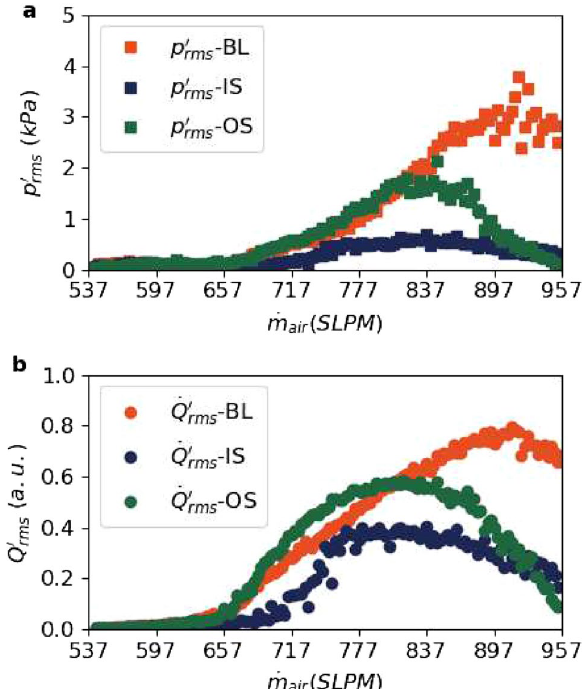
Figure 5. Time series of rms of the state variables that represent the global state of the system: p ′ and global heat release rate fluctuations: ˙ Q ′ that is obtained from PMT for experiments with baseline design of bluff body, IS and OS. ( a ) p ′ rms for BL, IS and OS bluff bodies and ( b ) ˙ Q ′ rms for BL, IS and OS bluff bodies. The global transition to thermoacoustic instability is suppressed for IS, while the suppression is not as effective for